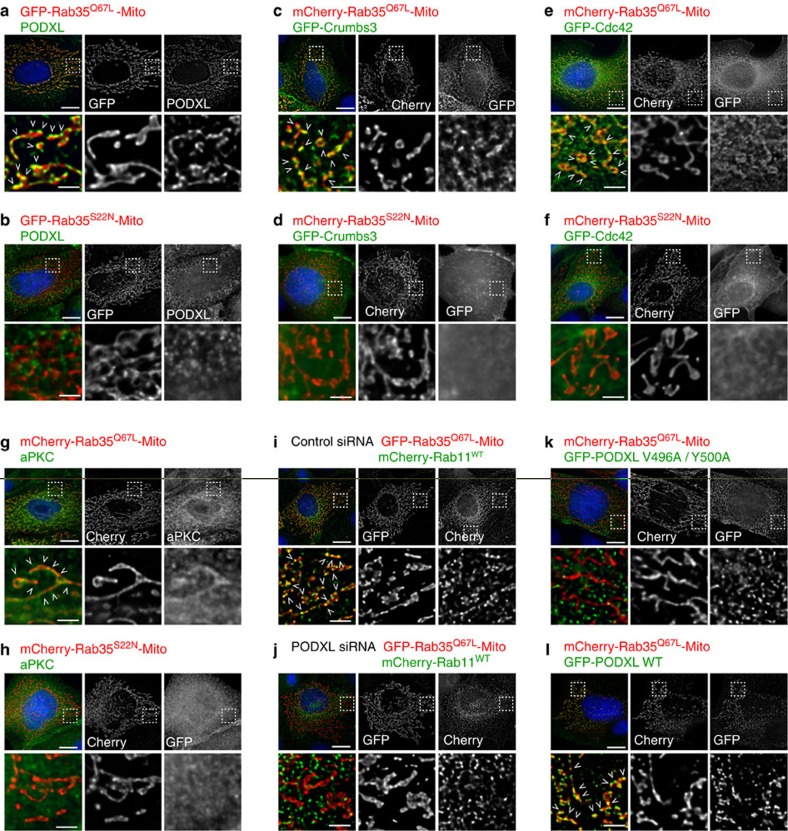
GTP-bound Rab35 acts a direct molecular tether for PODXL-positive vesicles transporting key apical determinants.(a–h) MDCK cells were transfected for 72 h with plasmids encoding either fluorescently tagged Rab35Q67L or Rab35S22N fused to the mitochondrial targeting signal of ActA (-Mito), as indicated. In the merged images, Rab35-Mito proteins are displayed in red, and PODXL, GFP-Crumbs3, GFP-Cdc42 or aPKC in green. (i,j) MDCK cells were treated with either control or PODXL siRNAs for 72 h, and co-transfected for 72 h with plasmids encoding mCherry-Rab11WT and either GFP-Rab35Q67L-Mito or GFP-Rab35S22N-Mito, as indicated. (k,l) MDCK cells were co-transfected for 72 h with plasmids encoding mCherry-Rab35Q67-Mito and either GFP-PODXL WT or GFP-PODXL V496A Y500A. In the merged images, Rab35Q67L-Mito is displayed in red, and PODXLWT or mutant in green. For a–l individual channels in grey levels and higher magnification of the regions delimited by a dash line are displayed, as indicated. Scale bars, 10 μm for unzoomed regions and 2 μm for zoomed regions. Arrowheads indicate examples of close-apposition vesicles (green) with mitochondrial Rab35Q67L (red).